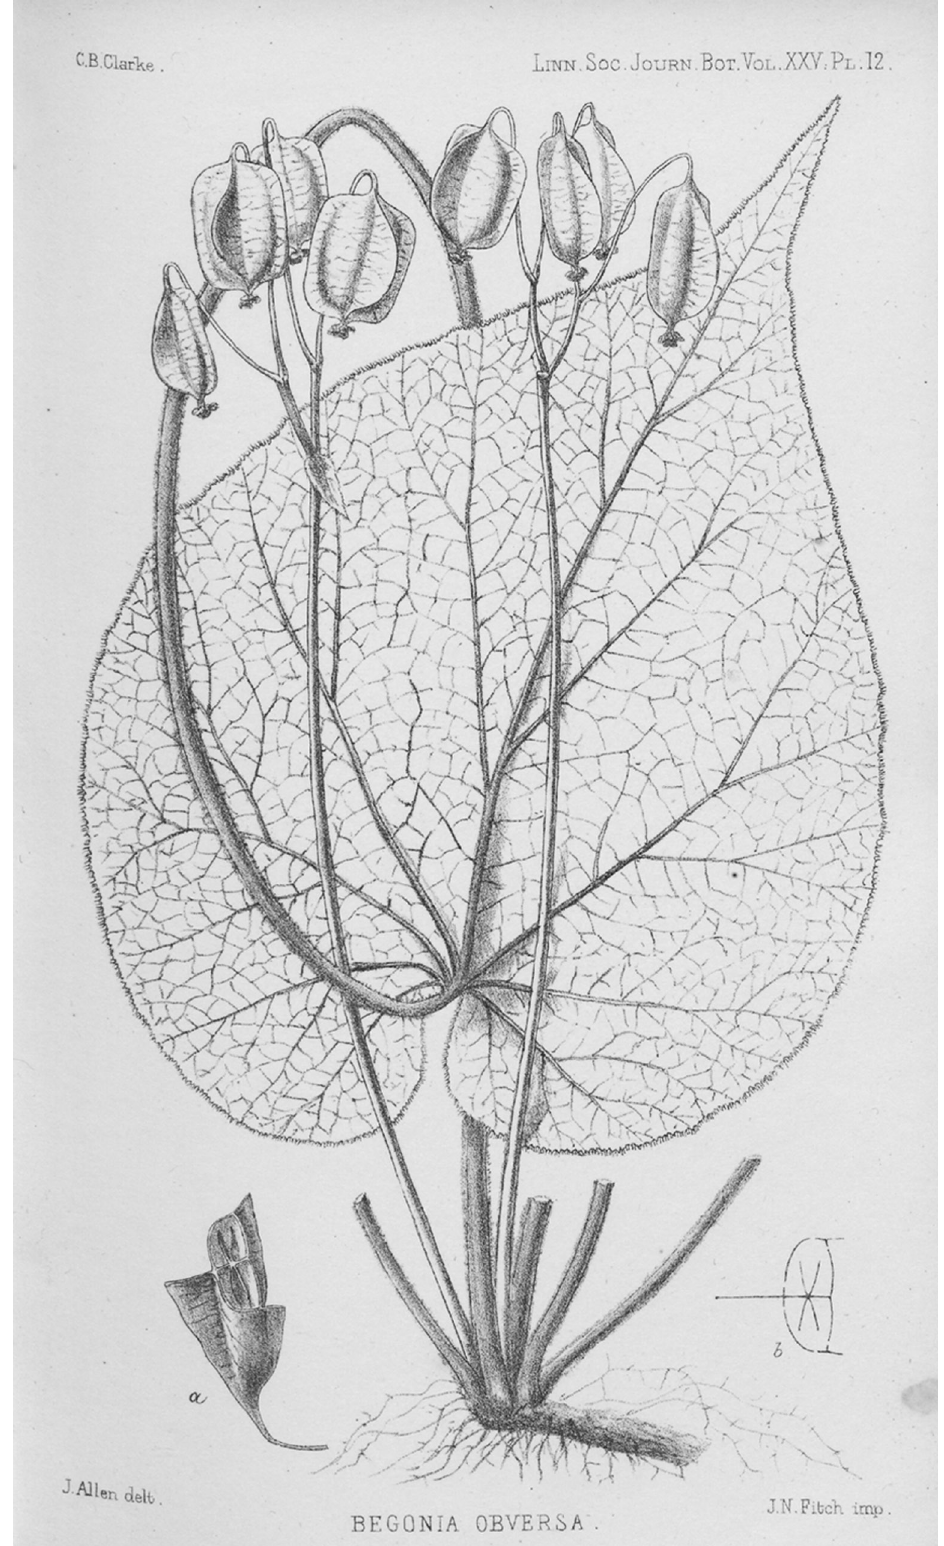
Fig. 42. Illustration of B. obversa C.B.Clarke by J. Allen (Clarke 1890). a. Fruit dissection. b. Diagram of fruit cross-section. Image courtesy of RBGE library and Lynsey